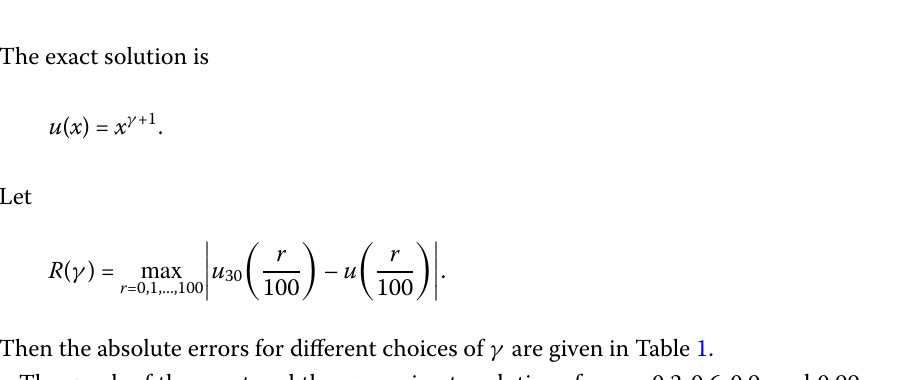
Figure 1 The exact and the approximate solutions for γ = 0.3,0.6,0.9, and 0.99, dots: approximate solutions, joint lines: exact